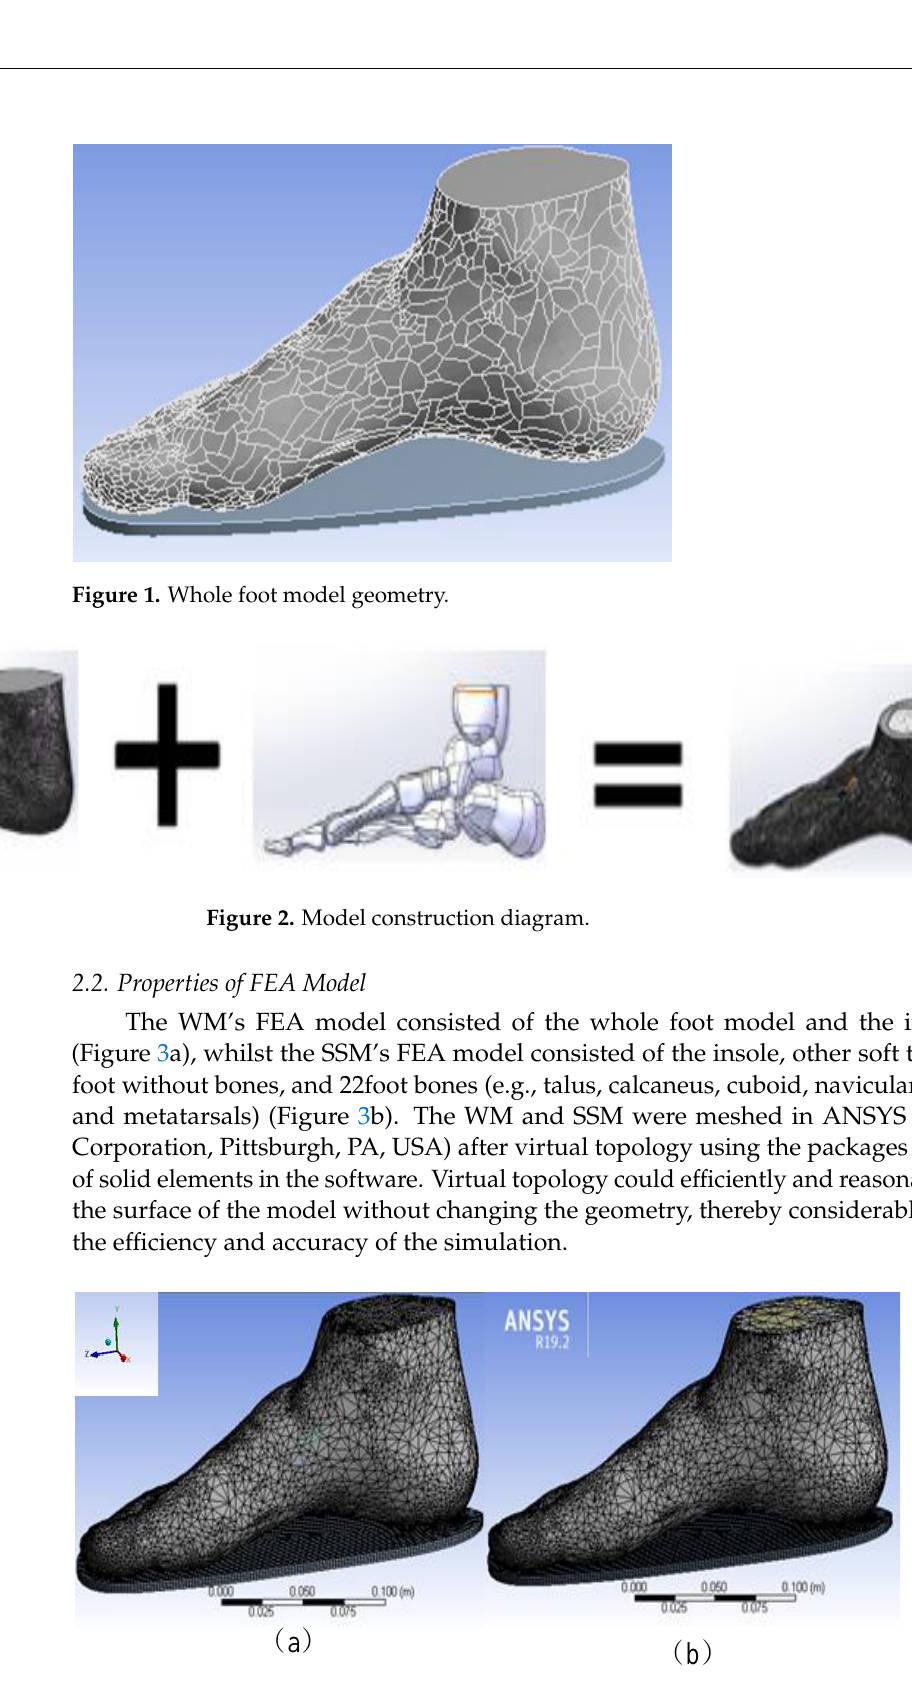
Figure 3. Finite element analysis (FEA) model of ( a ) the whole model (WM) and ( b ) the skeletal structure foot model